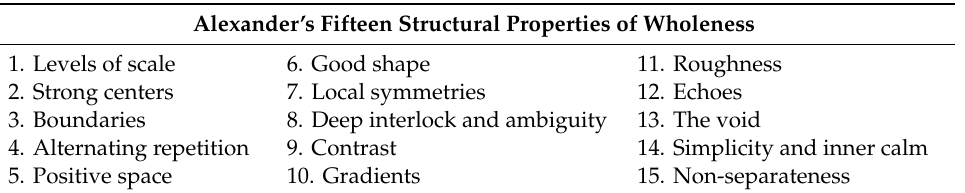
Table 1. Alexander’s 15 properties of wholeness [1] (pp.